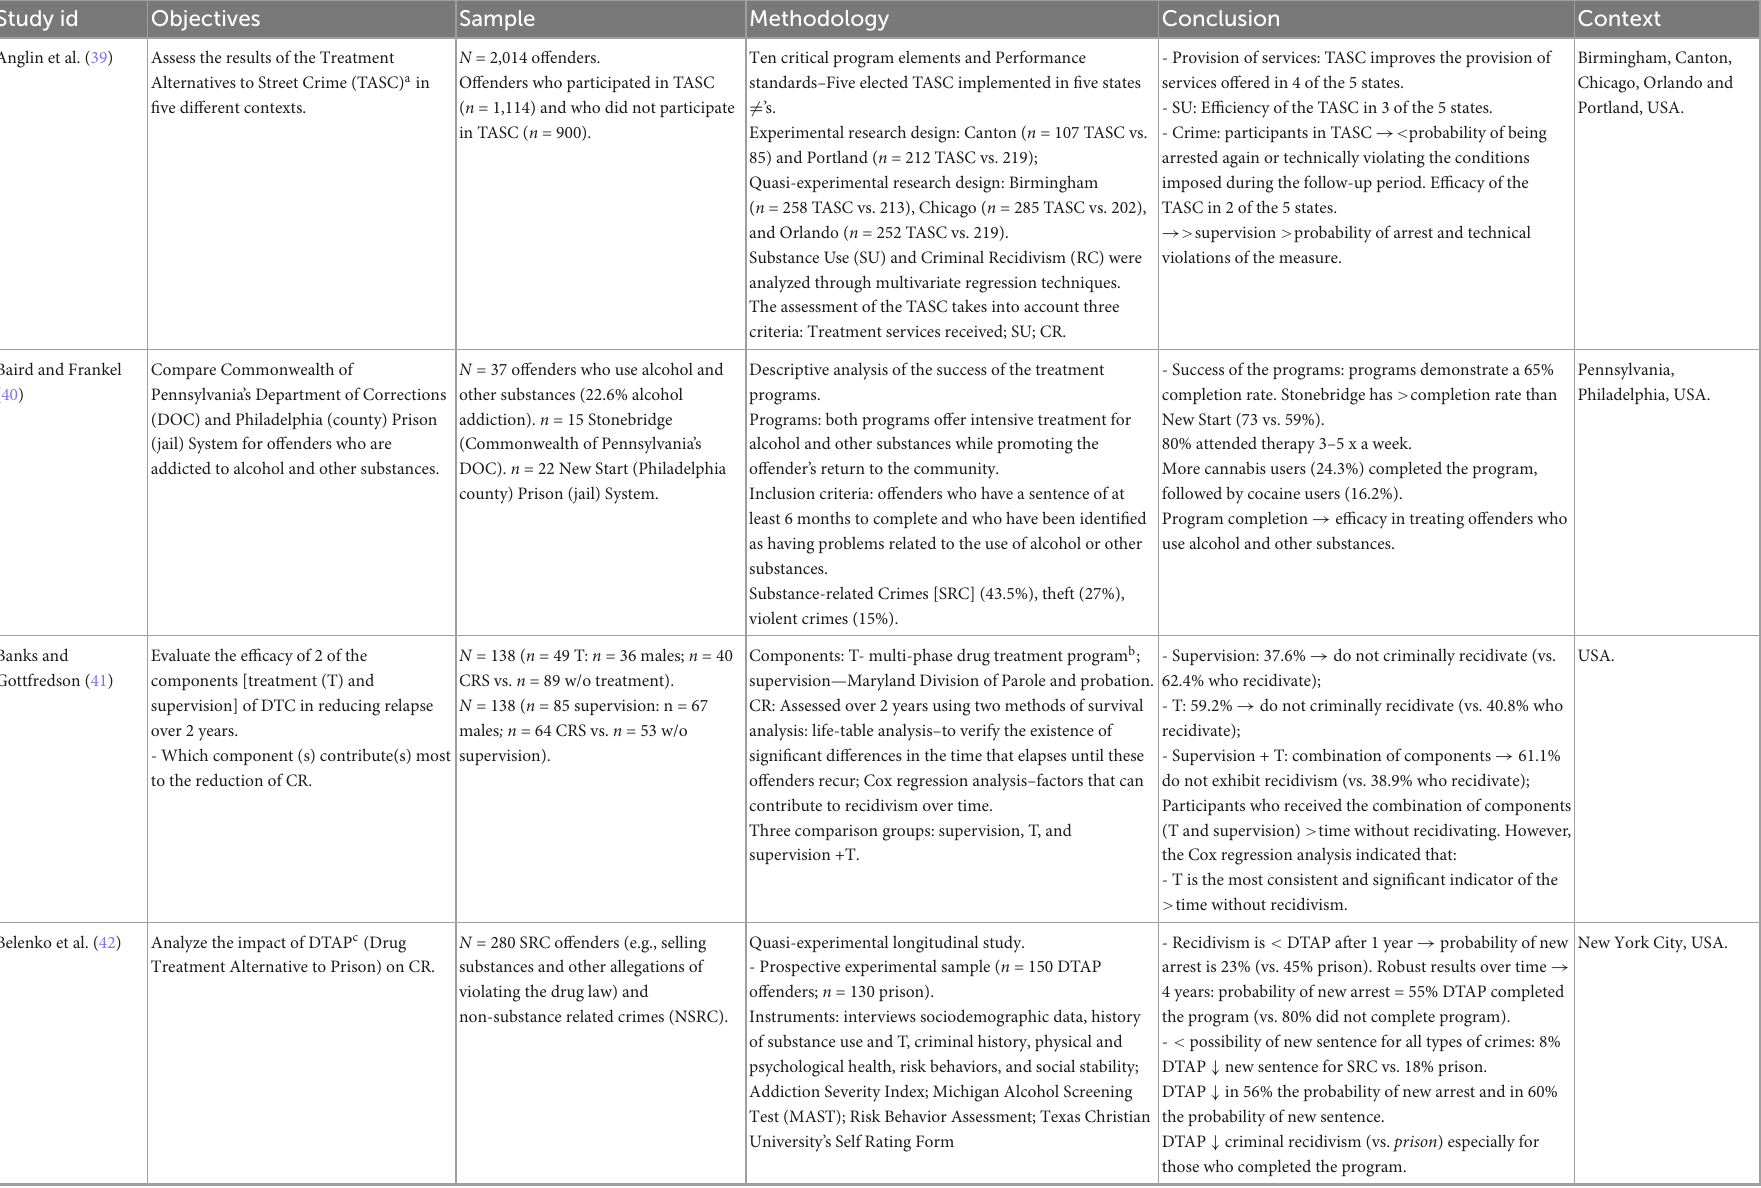
TABLE 1 Summary of studies’